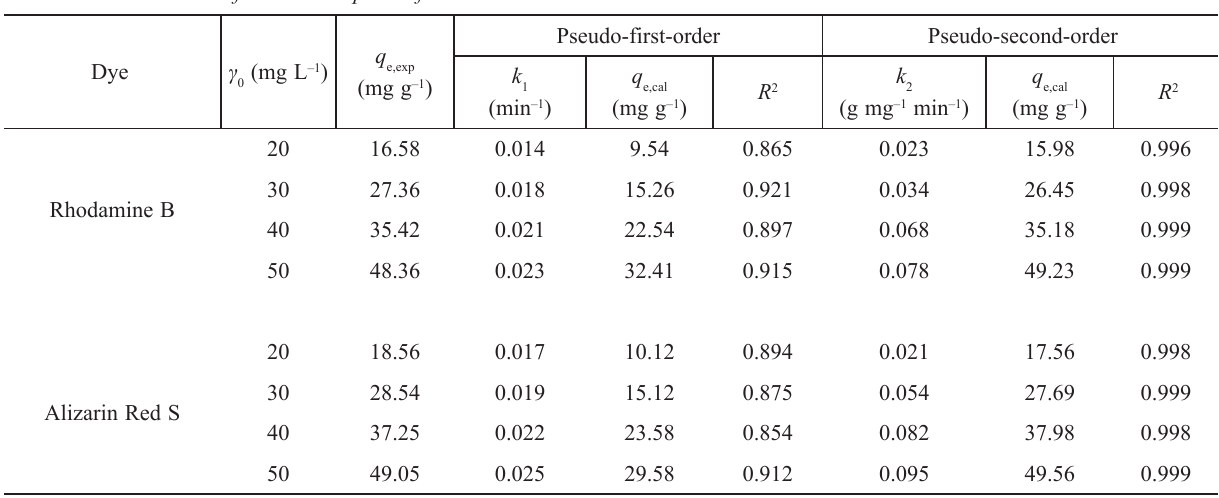
Table 3 – Kinetic data for the adsorption of Rhodamine B and Alizarin Red S onto CES adsorbent